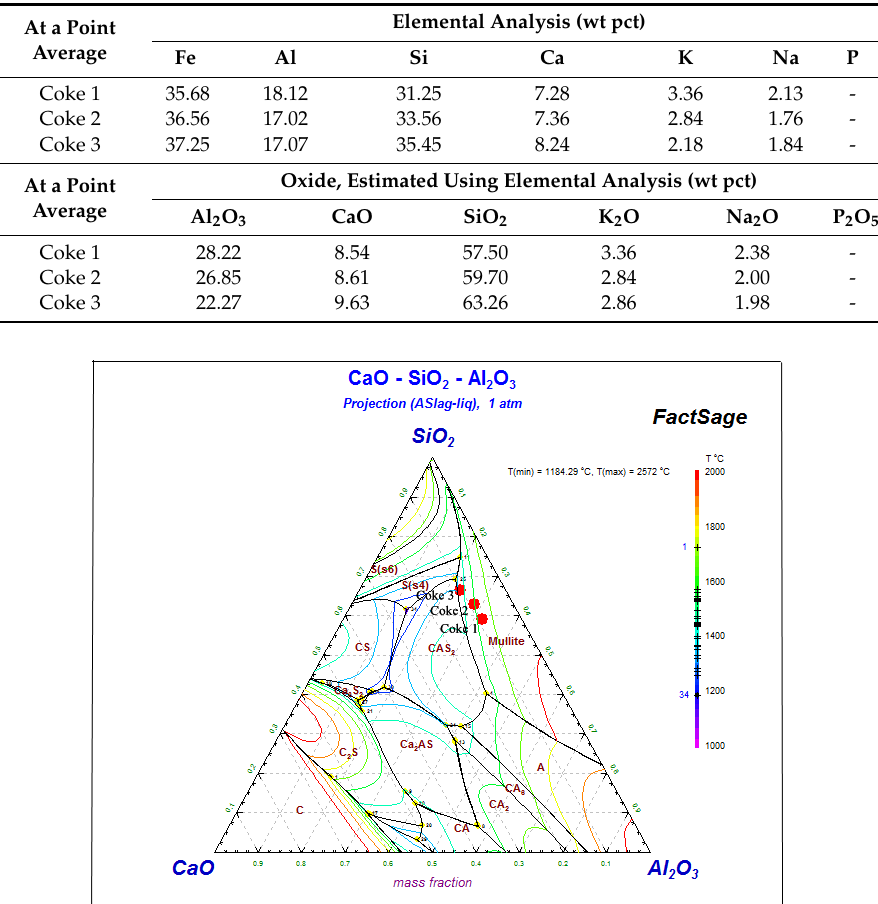
Figure 6. CaO-SiO 2 -Al 2 O 3 slag system phase diagram of the partially dissolved coke sample surface.